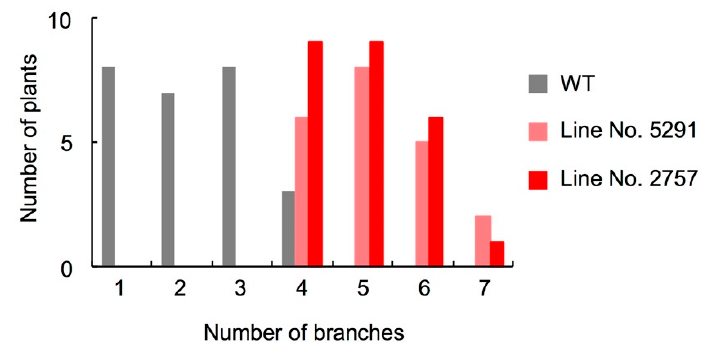
Figure 3. Number of branches in WT and SlCCD8 -defective mutants. Axillary buds longer than 2 mm were counted in 30-day-old seedlings. WT, n = 26; line 5291, n = 29; line 2757, n = 25.